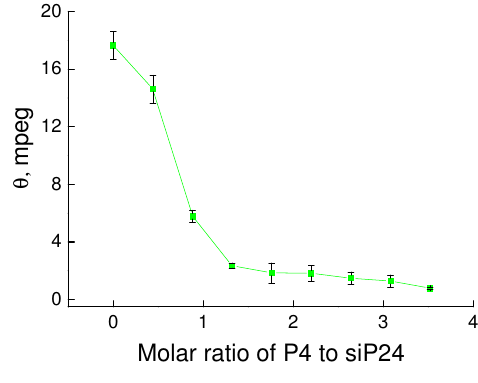
Figure 3. Changes in molar ellipticity of siP24 upon addition of P4 dendrimer. λ = 262 nm. [siP24] = 10 µ max.